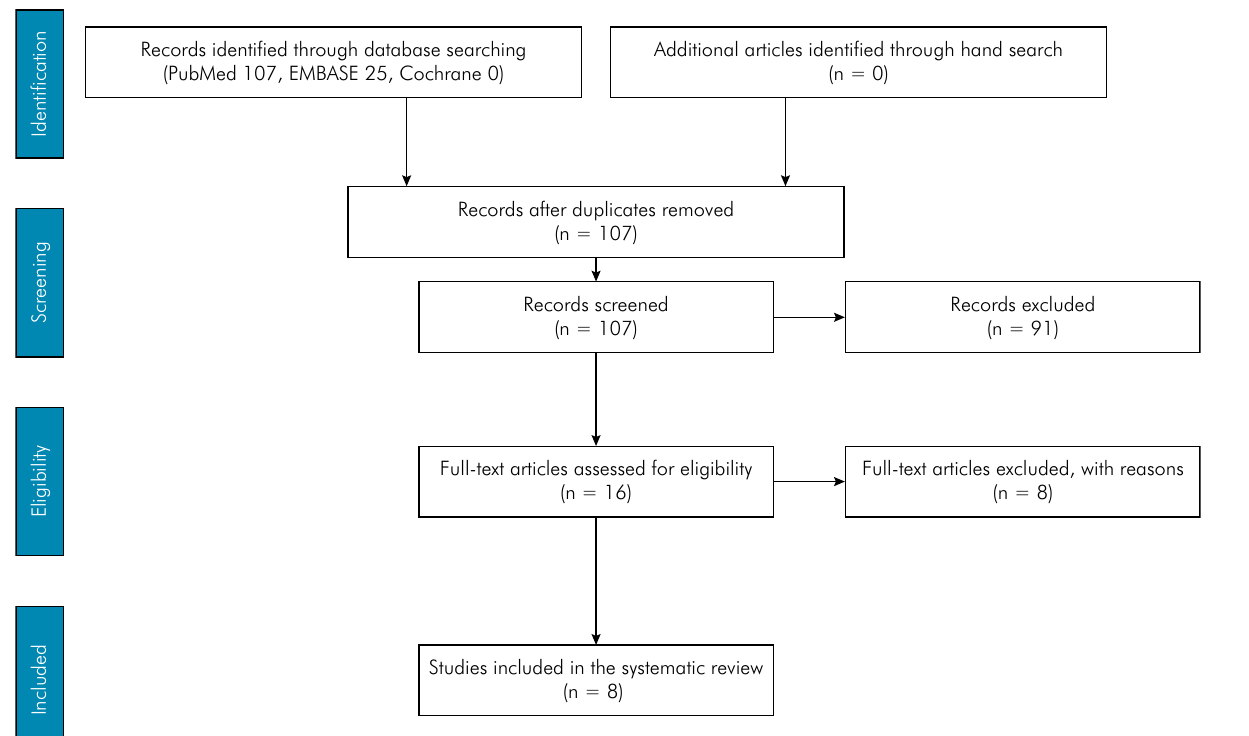
Figure 1. Flow chart of paper